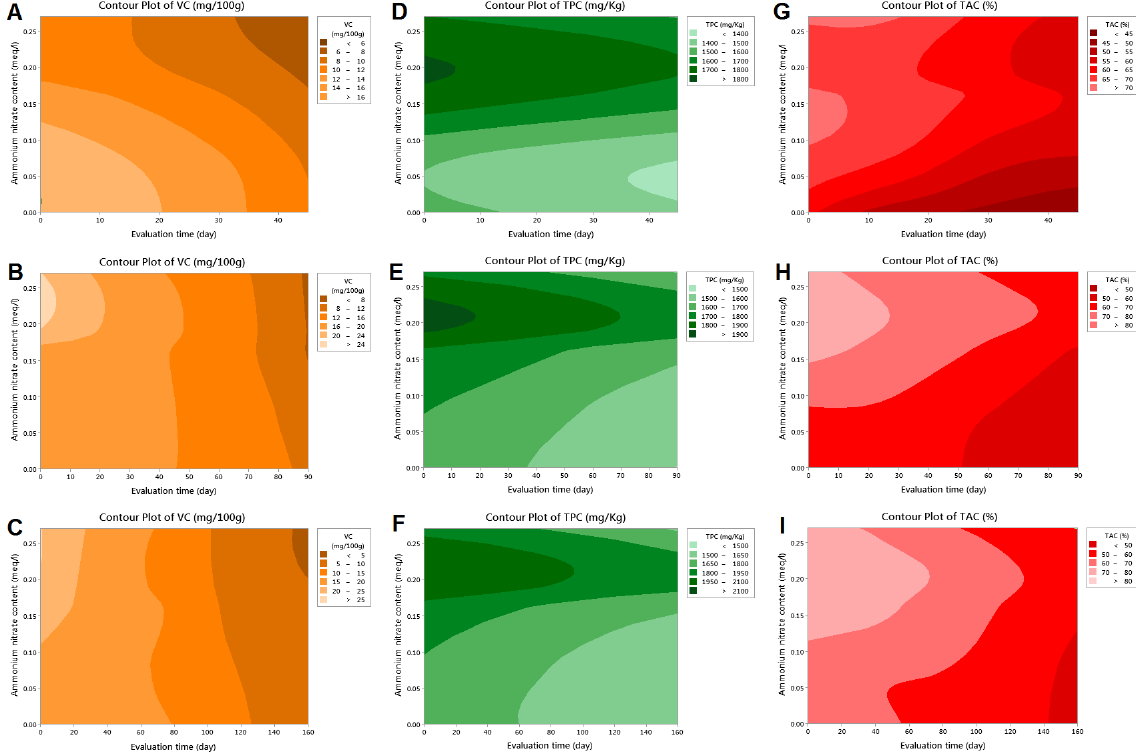
(A, B, and C) (G, H, and I) , total phenolic compounds (TPC) (mg/Kg) in the three studied apple cultivars: ‘Golab Kohans’